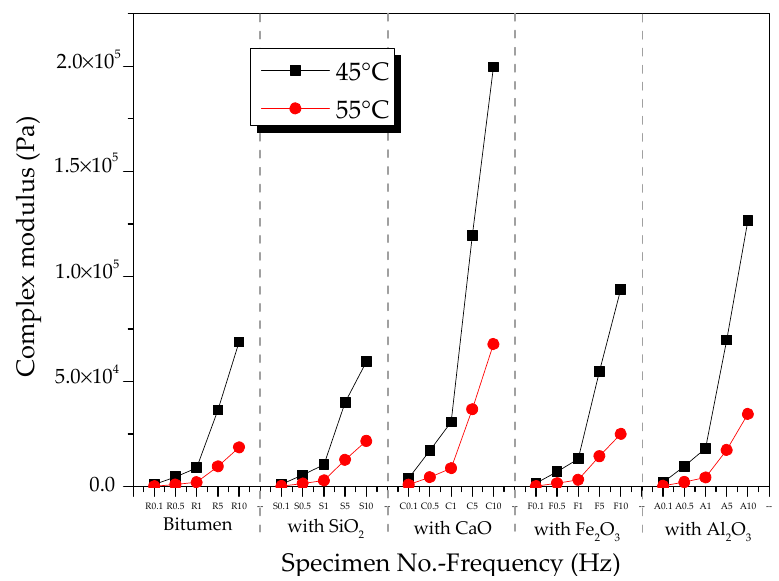
Figure 5. Effects of temperature on complex shear modulus of modified bitumen–oxide mixtures. Figure 5. E ff ects of temperature on complex shear modulus of modified bitumen–oxide